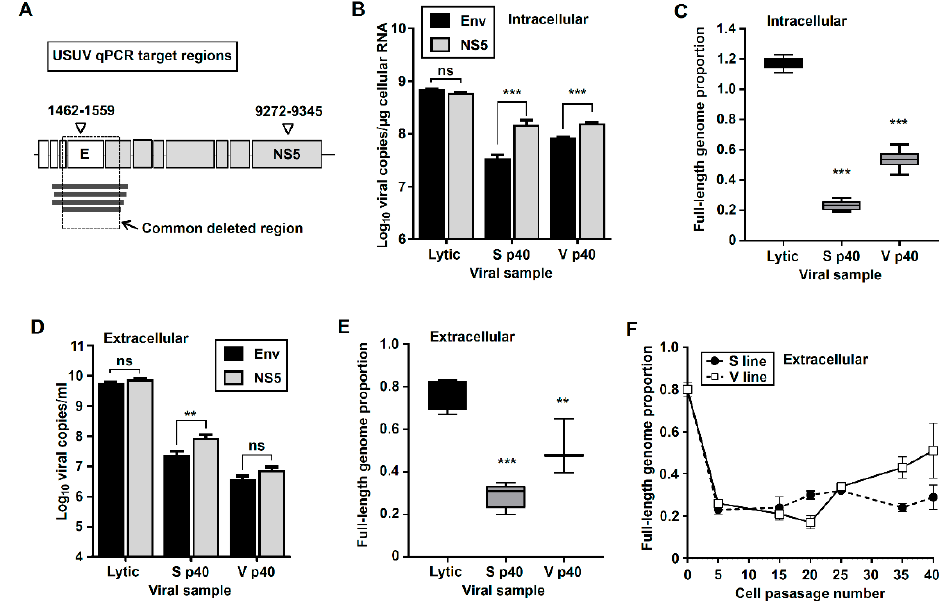
Figure 3. Detection of defective viral genomes in persistently-infected cells. ( A ) Illustration of USUV genome and target sequence sites for different qPCR strategies. Different deletions found in V and S defective genomes are shown as thick dark grey lines, and a square indicates the common deleted region in these different sequences. The procedures for each qPCR detection method are described in Materials and Methods. Methods for the detection of non-structural protein 5 (NS5)-coding region are used for the quantification of total viral RNA molecules (including both standard and truncated viral genomes). Methods for the detection of the Env-coding region are used for the specific detection of standard genomes (excluding defective genomes). ( B , C ) Intracellular detection of viral RNA. B, quantification of intracellular viral RNA in lytically- and persistently-infected cells using qPCR detection methods for Env (black bars) or NS5 (grey bars) coding regions. Each bar represents the average of values obtained from independent cell monolayers ( n > 5). ( C ) Estimated ratio of standard length genomes in the sample (viral RNA molecules detected with Env relative to NS5, based on results shown in (B). ( D , E ) Same as in B and C but in samples extracted from cellular supernatants ( n > 3). ( D ) Quantification of extracellular viral RNA using qPCR detection methods for Env (black bars) or NS5 (grey bars) coding regions. Each bar represents the average of values obtained from independent cell monolayers ( n > 5). ( E ) Estimated proportion of full-length genomes in the supernatant of V and S cells at p40, and Vero cells infected with wild type USUV. ( F ) Proportion of full-length genomes in the supernatants of S and V cells along passages. Statistically significant differences are represented by asterisks (* p < 0.05, ** p < 0.01, *** p < 0.001). B and D, one-way ANOVA test. C and E, two-way ANOVA test.